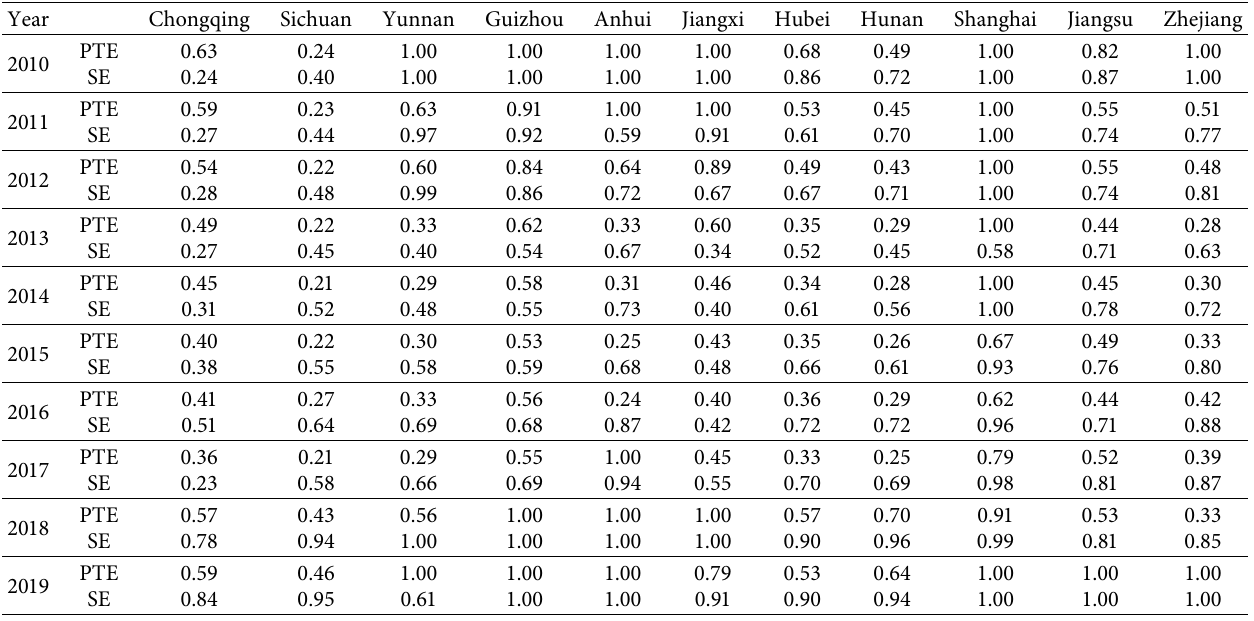
Data source: calculated according to the Chinese statistical system.